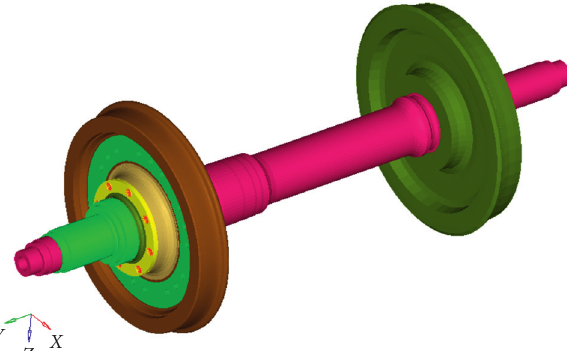
Figure 2: Entire wheel sets and axle finite-element model.